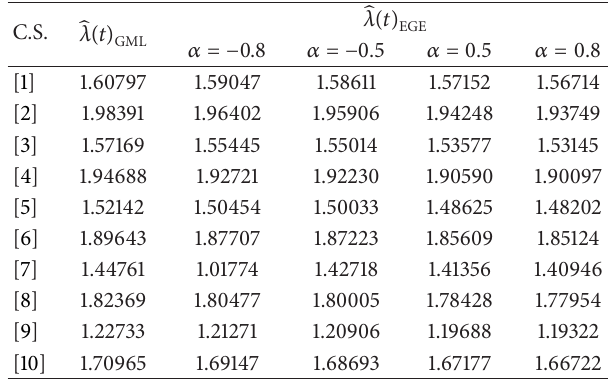
Table4:GMLandEBestimatesofreliability 𝑅(𝑡) fordifferentvalues of 𝛼 .